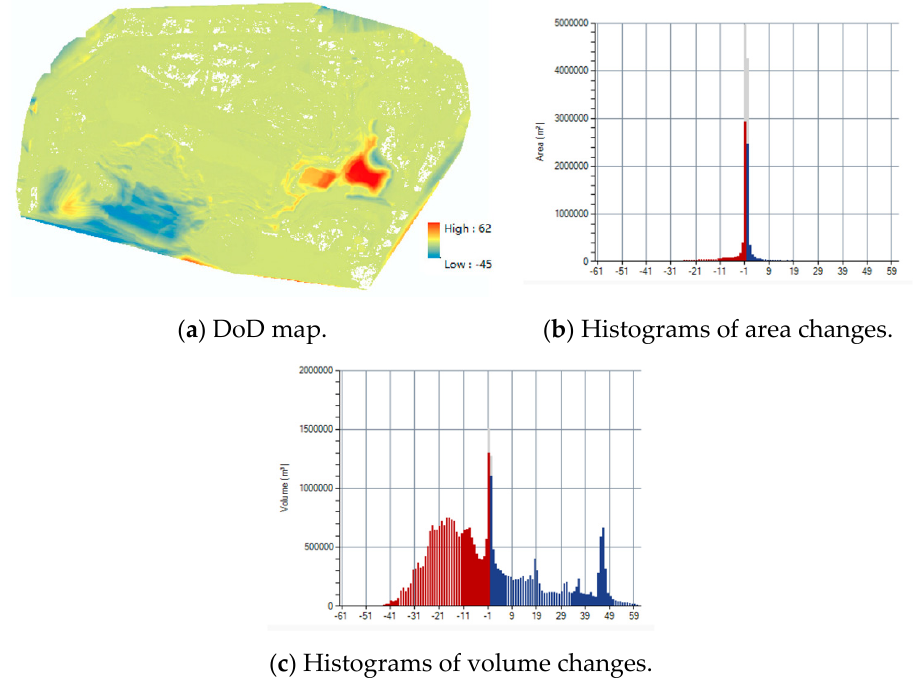
Figure 5. DoD for the period from August 2020 to December 2020 and area and volumetric ECDs for Pit 4.